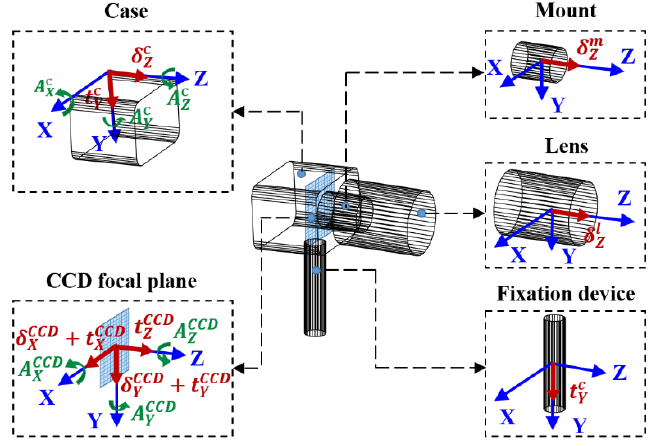
Figure 1. Thermal behaviours of the components in a typical digital camera system used in photo mechanics measurements.